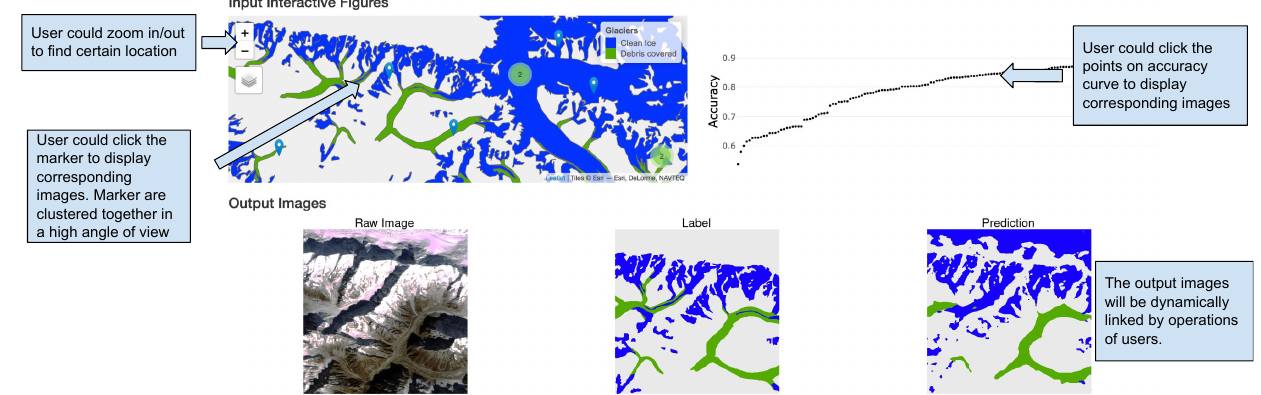
Figure 8. Screenshot of the Shiny app with annotations. Users could interact with the app through the upper part of the app. Users could click the map and loss curve to switch the prediction results in the lower part of the